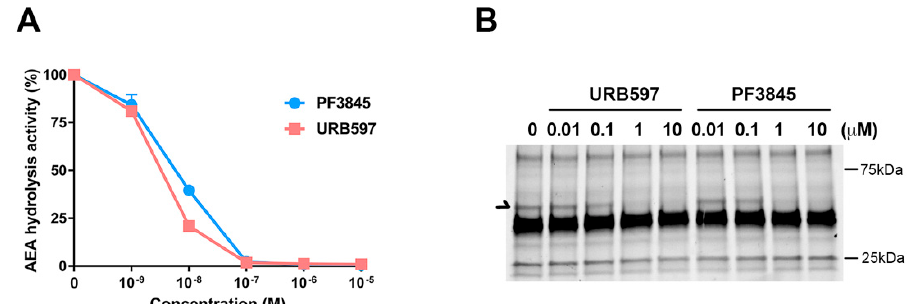
Figure 1. Characterization of the fatty acid amide hydrolase (FAAH) inhibitors URB597 and PF3845. AEA hydrolytic activity in BV2 membrane in the presence of inhibitor was assayed by measuring radioactive ethanolamine production by hydrolysis from [ 14 C]-AEA. The plots for PF3845 dose response as a blue line and URB597 as an orange line are represented as relative activity with means ± S.D. (n = 3) ( A ). Activity-based protein profiling probe (ABPP), using the FP-TAMRA serine hydrolase probe, was performed in BV2 membrane fraction after treatment with the FAAH inhibitors. Arrow indicates the signal corresponding to FAAH ( B ).